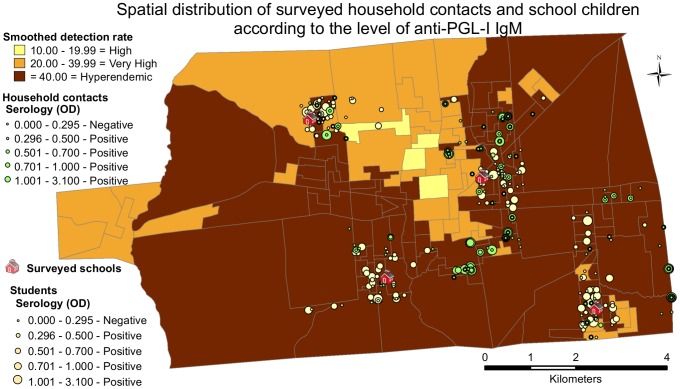
Spatial distribution of surveyed household contacts and school children.The spatial distribution of surveyed household contacts and school children according to their level of antibodies compared to the level of endemicity of the different census tracts.